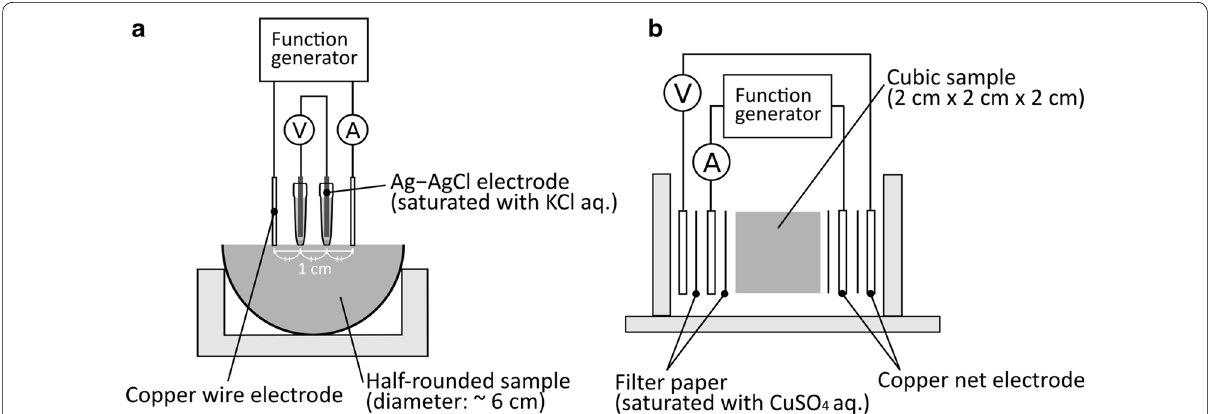
Fig. 2 Schematic configuration of resistivity and IP measurements for a unconsolidated sediments and b consolidated rocks